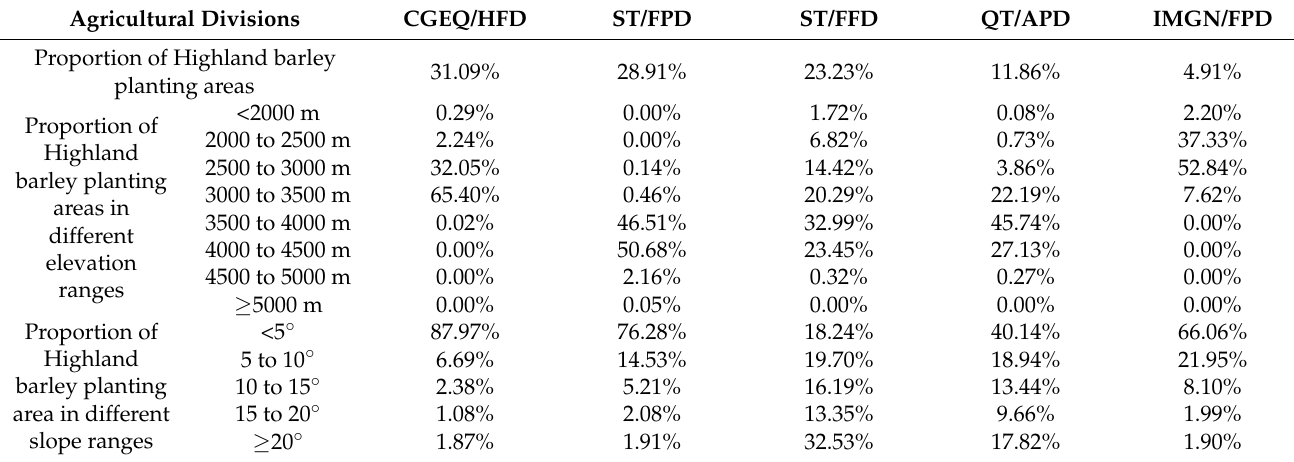
Table 4. Statistics of Highland barley planting areas in various agricultural